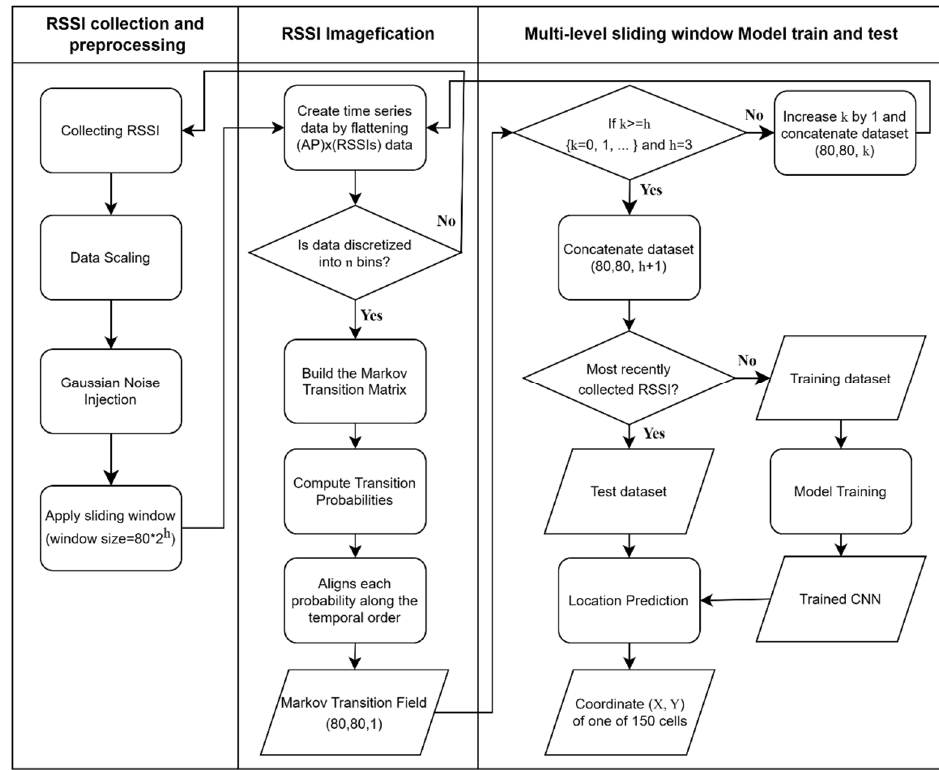
Figure 7. The overall process from the collection of RSSIs to the model training and testing.